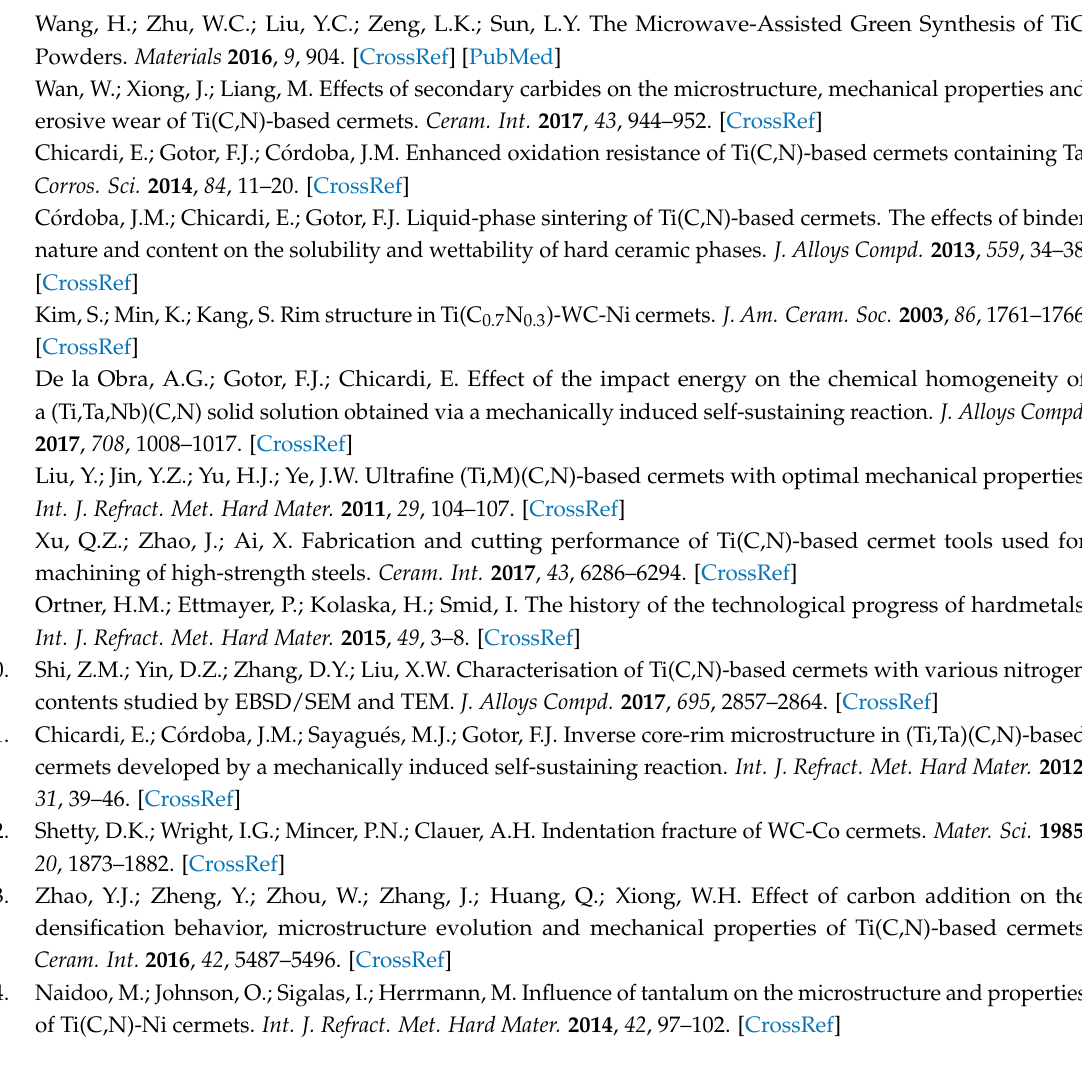
Figure S1: The curve of transverse rupture strength for cermets prepared by the extra solid phase, Figure S2: SEM micrographs of microstructure in Ti(C,N)-based cermets sintered at 1300 ◦ C for 0 h (a) and 2 h (b), Figure S3: XRD patterns of Ti(C,N)-based cermets sintered at 1300 ◦ C for 0 h and 2